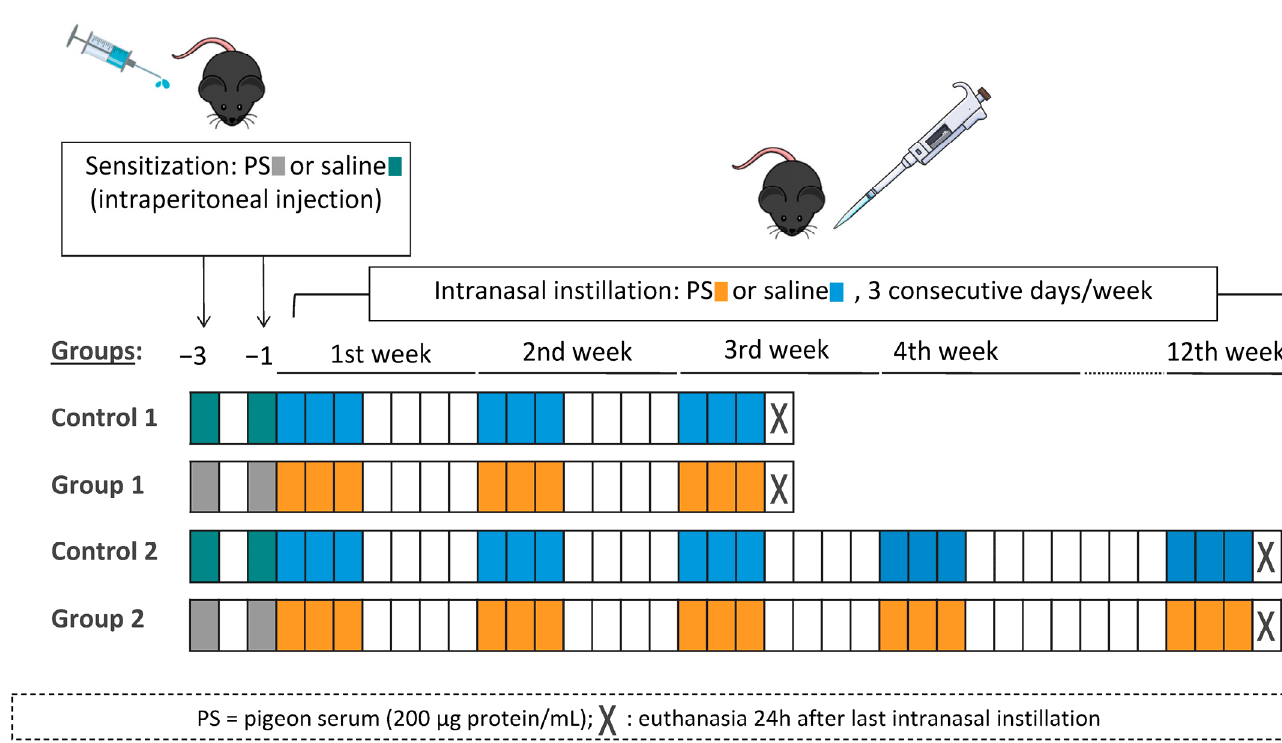
Figure 8. Flow chart of the experimental design and the four experimental groups. Mice were sensitized by intraperitoneal injection with 100 µ L of pigeon serum (PS) or saline on days − 3 and − 1 and then received intranasal instillations of 40 µ L of PS or saline on three consecutive days/week for 3 weeks (Group 1) or 12 weeks (Group 2). Mice were sacrificed 24 h after the last intranasal instillation.